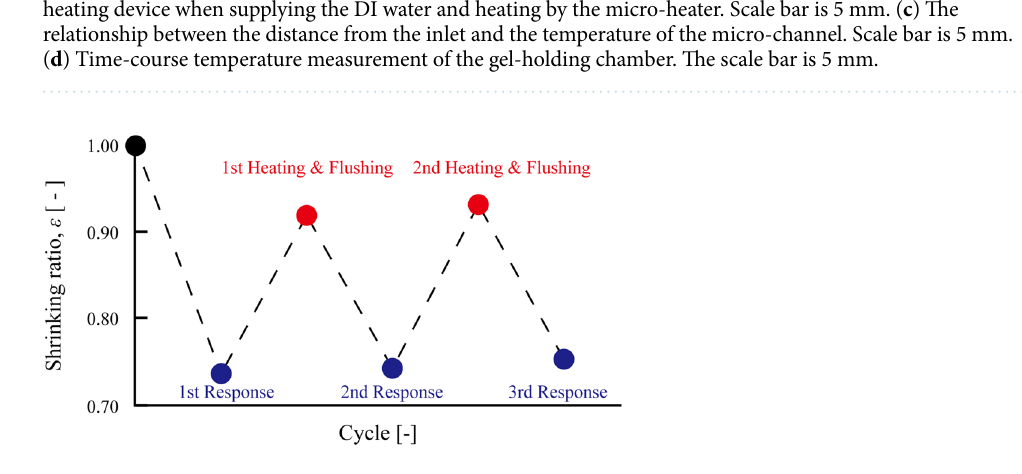
Figure 4. The repeatable detection of Ag + ions by using the DNA aptamer-linked hydrogel biochemical